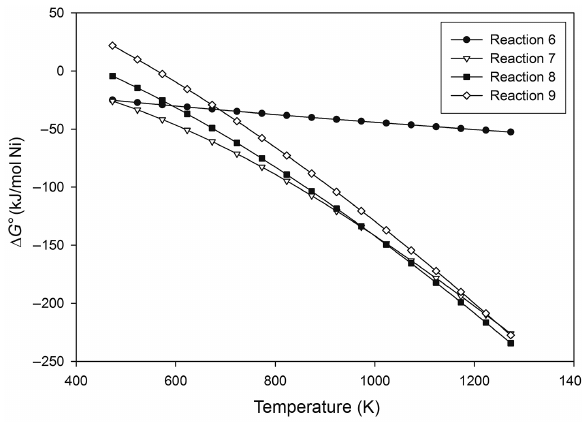
Figure 2: Standard-free energy changes ( Δ G °) for the reactions involving nickel.